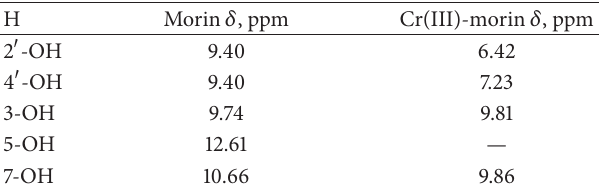
Table 1: 1 H NMR data for morin and Cr(III)-morin complex.